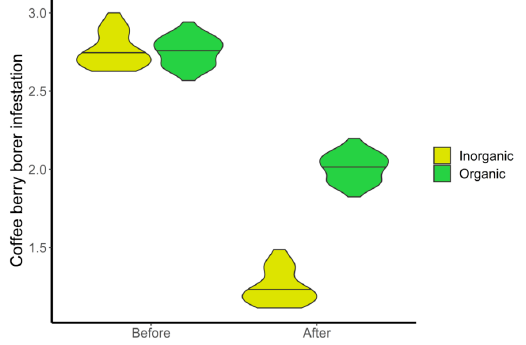
type effect: β = 0.76 ± SE 0.24, t-value = 3.17, p = 0.003), and this was dependent to the inorganic and turned into organic (stage*farming type interaction effect: β = 0.77 ± SE 0.29, t-value = 2.69, p = 0.009). The initial value of the infestation, in fact, was similar between organic and inorganic plantations (Figure 6).